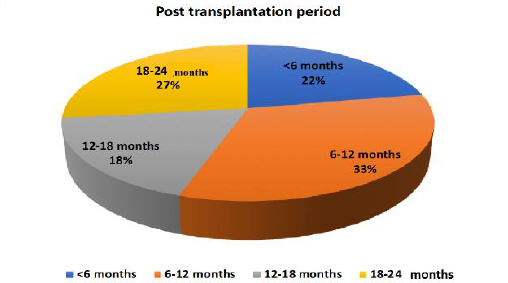
Fig. 1. Post-transplantation period (PTP) among kidney transplant